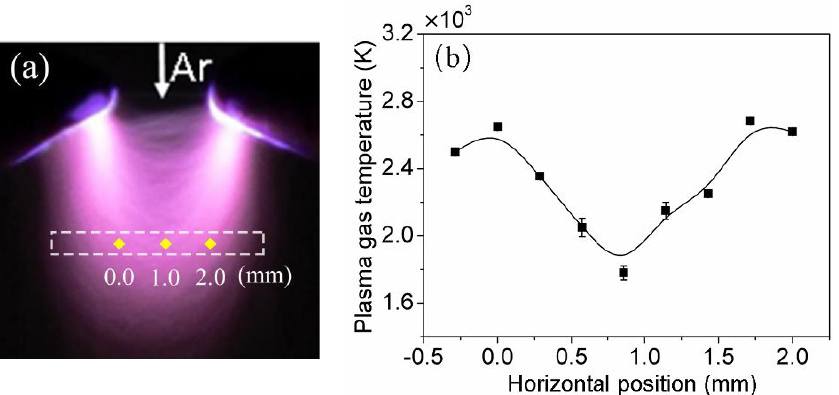
Figure 6. ( a ) Measurement area of plasma gas temperature; ( b ) the distribution of plasma gas temperature with horizontal position (Ar flow rate: 1.68 L/min, discharge gap: 2 mm, applied voltage: 5.6 kV).